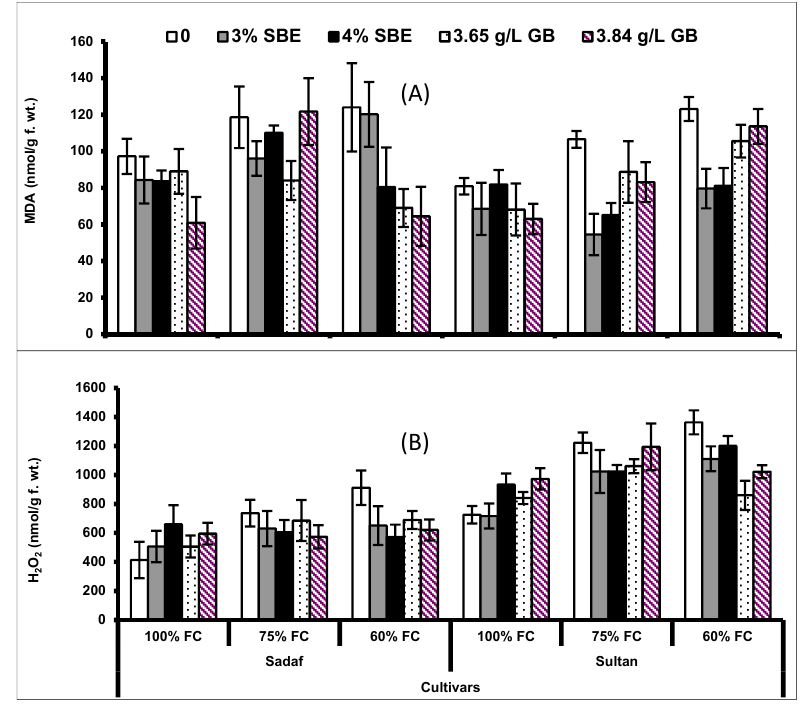
Figure 5. ( A ) Malondialdehyde (MDA) and ( B ) hydrogen peroxide (H 2 O 2 ) of two maize cultivars foliar-fed with varying levels of sugar beet extract (SBE) and glycine betaine under water deficit conditions (Mean ± S.E.).